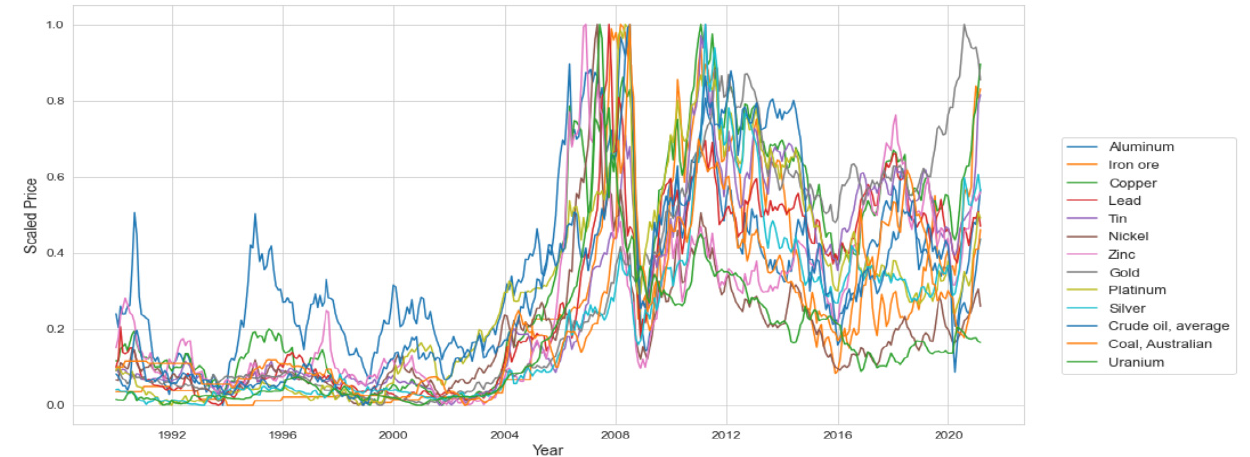
Figure 1. Min–max scaled prices for the different mineral commodities.